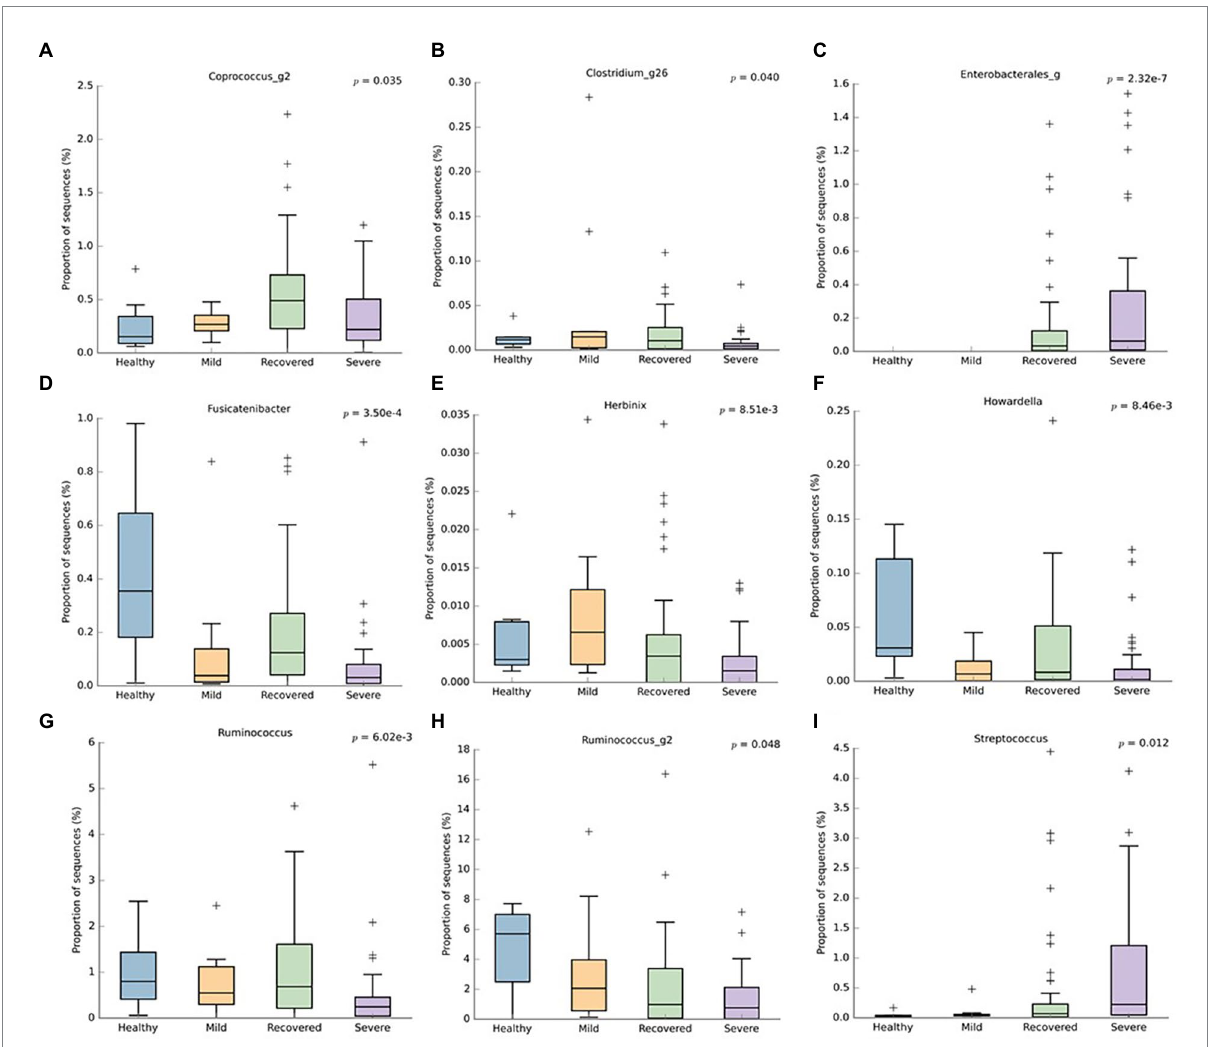
FIGURE 4 Boxplots representing the relative abundance of significant bacterial genera: (A) Coprococcus_g2 , (B) Clostridium_g26 , (C) Enterobacterales , (D) Fusicatenibacter , (E) Herbinix , (F) Howardella , (G) Ruminococcus , (H) Ruminococcus_g2 , (I) Streptococcus . This analysis was performed with Welch’s t-test and an effect size filter of 0.05, to compare the abundance differences between the